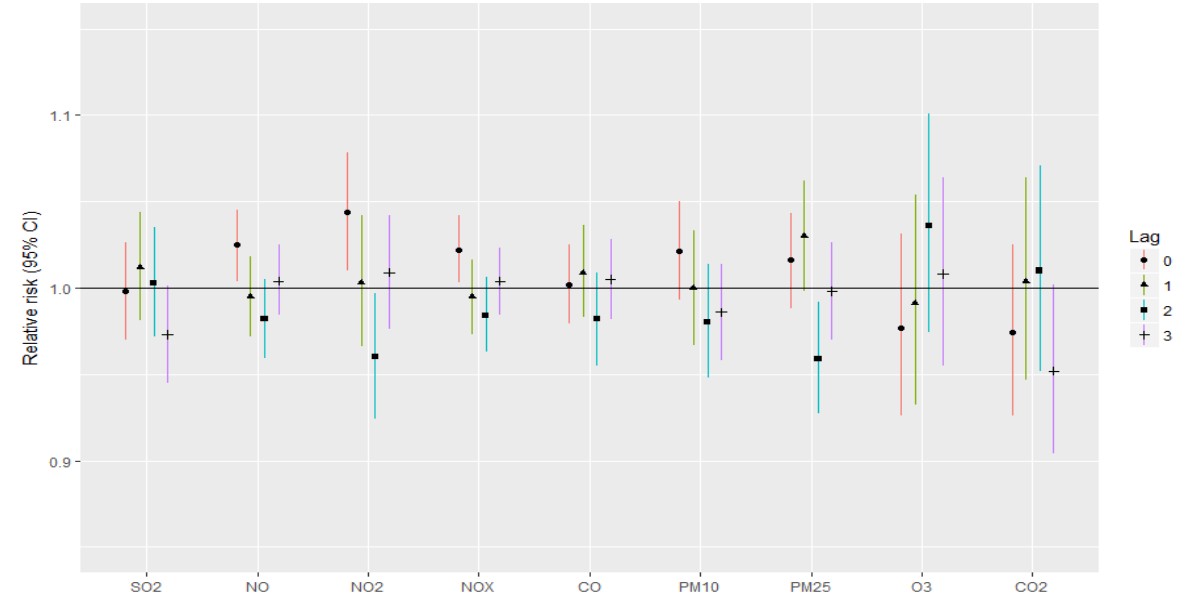
Figure 1. Relative risk of stroke for IQR changes in air pollutant levels for different lags in single- pollutant models.